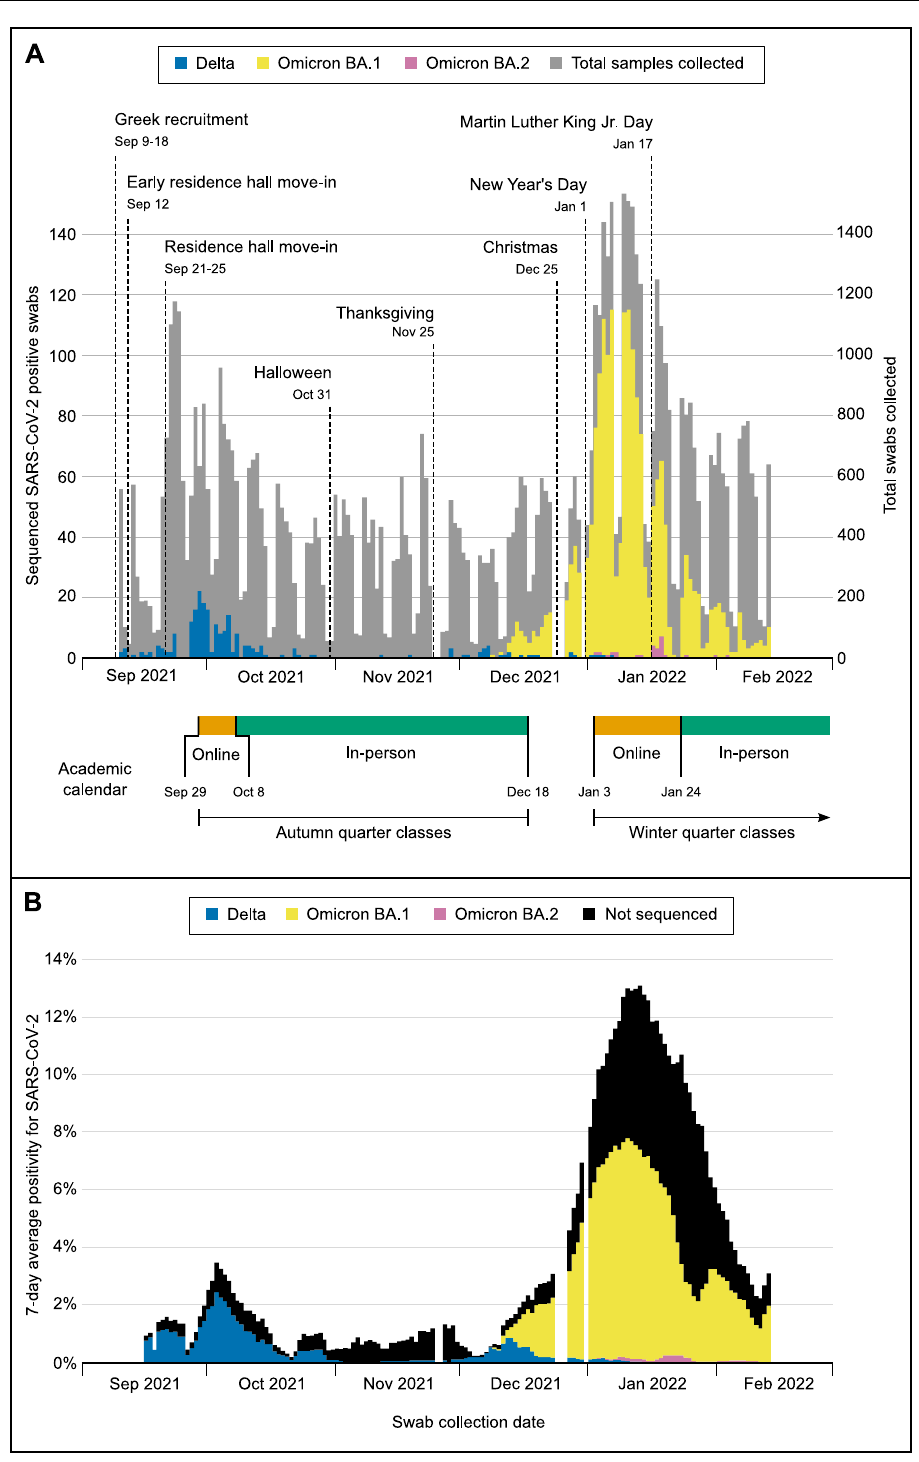
Fig. 1 | Sequenced SARS-CoV-2-positive samples collected from September 10, 2021 to February 14, 2022, by Pango Lineage. A Daily counts of total samples collected and positive samples. B SARS-CoV-2 7-day average percent positivity. Campus events, holidays, and breaks in coursework that impacted university